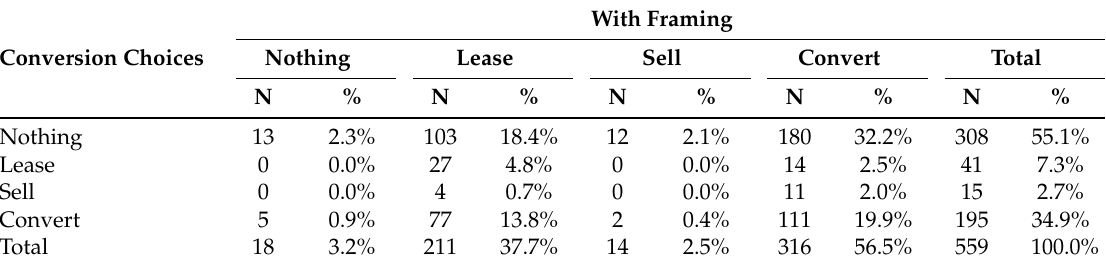
Table 5. Choices in framed risk game contrast with field behavior. With Framing